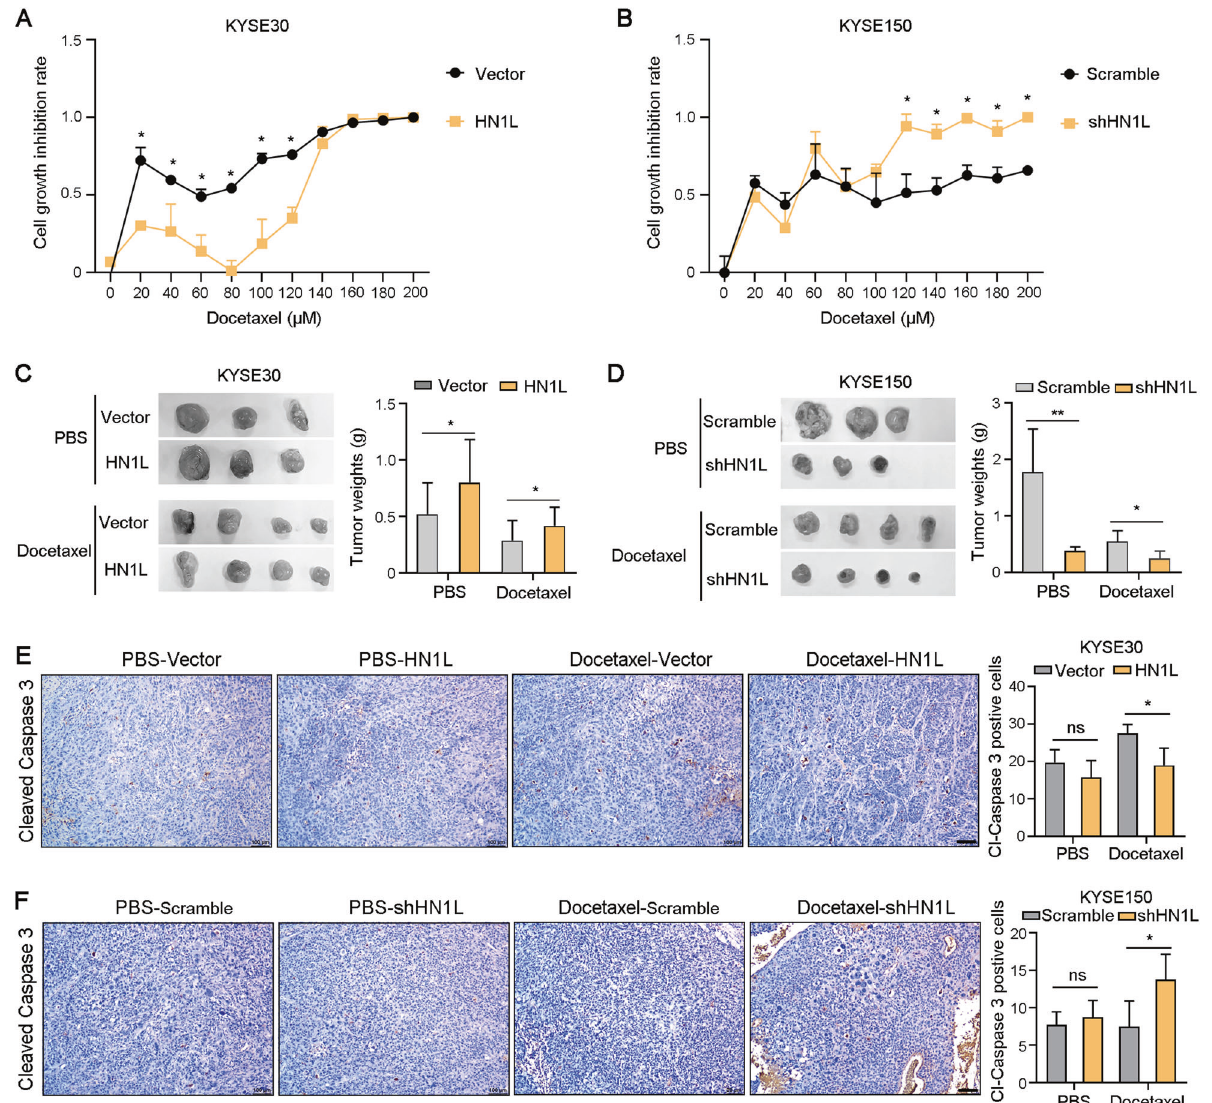
Vector and KYSE30- HN1L cells were transplanted subcutaneously into nude mice and treated with Docetaxel. Xenograft tumor weights were counted in the right panel. D Xenograft tumor experiment was performed using KYSE150-scramble and KYSE150-sh HN1L cells and treated with Docetaxel. E , F IHC staining with antibodies against cleaved Caspase 3 was performed on xenograft tumors. And the number of cleaved Caspase 3-positive tumor cells was counted. Scale bar, 100 μ m. In all panels, data are presented as the mean ± SD; two-sided Student ’ s t